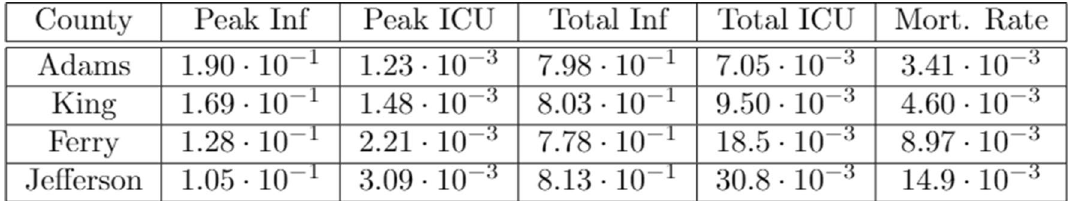
Figure 9. County infected/ICU statistics.